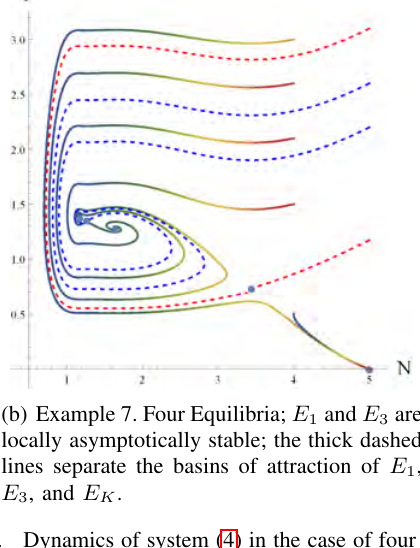
(b) Example 8. Dynamics of the model (4) in the vicinity of E 1 and E 3 . Trajectories either tend to a limit cycle, or to E 3 , depending on the initial condition. Fig. 14. Dynamics of system (4) in the case of one stable and three ustable internal equilibrium points. Example